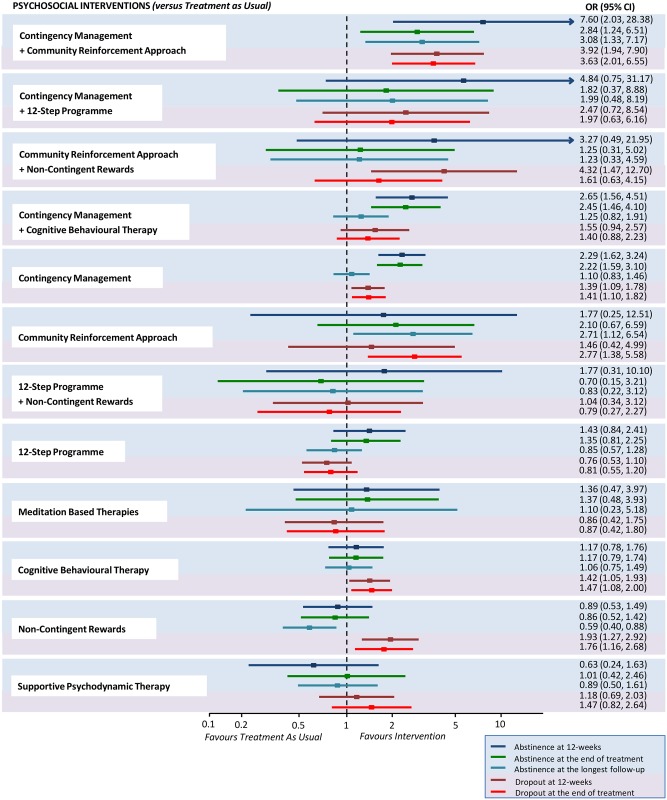
Abstinence and dropout at different time-points for each psychosocial intervention versus treatment as usual.Estimates are reported by ORs, where an OR above 1 favours the psychosocial intervention indicated on the left side over treatment as usual. For each intervention, efficacy outcomes are reported in the blue-shaded area, while acceptability outcomes are reported in the pink-shaded area. OR, odds ratio.